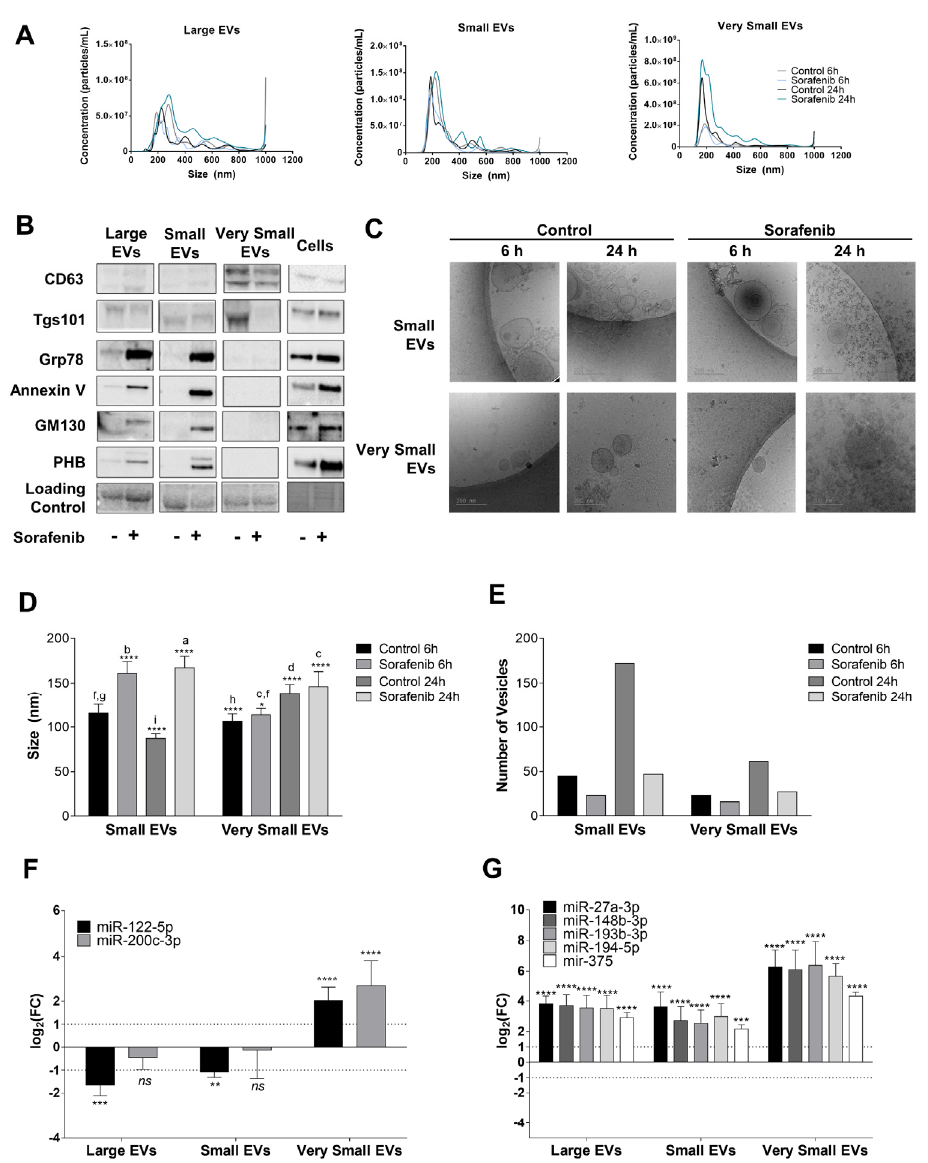
Figure 4. Extracellular vesicle secretion induced by Sorafenib and their miRNA content. ( A ) Particle size and concentration analysis of Large, Small, and Very Small EVs obtained at 6 and 24 h. ( B ) Expression of EV markers and cellular contaminants in Large, Small, and Very Small EVs and cell lysates obtained at 24 h after Sorafenib treatment. Total lane protein content was used as the loading control. ( C ) Representative images of cryo-EM of Small and Very Small EVs obtained at 6 and 24 h from the control and Sorafenib-treated cells. ( D ) Assessment of EV size (nm) in the cryo-EM images. ( E ) Number of EVs quantified in the cryo-EM images. ( F ) miRNA expression in the three fractions of EVs at 6 h. ( G ) miRNA expression in the three fractions of EVs at 24 h. Fold-change values were calculated between Sorafenib and the control treated samples. Results are expressed as the mean ± SEM of six independent experiments. Ns, non-significant; * p ≤ 0.05 ** p ≤ 0.01, *** p ≤ 0.001, and *** p ≤ 0.0001 between the miRNA expression in the control and Sorafenib derived EVs. Multiple com- parison test statistics are expressed with lower case a–i. 3.5. Expression of Circulating miRNAs as Biomarkers of Disease Prognosis